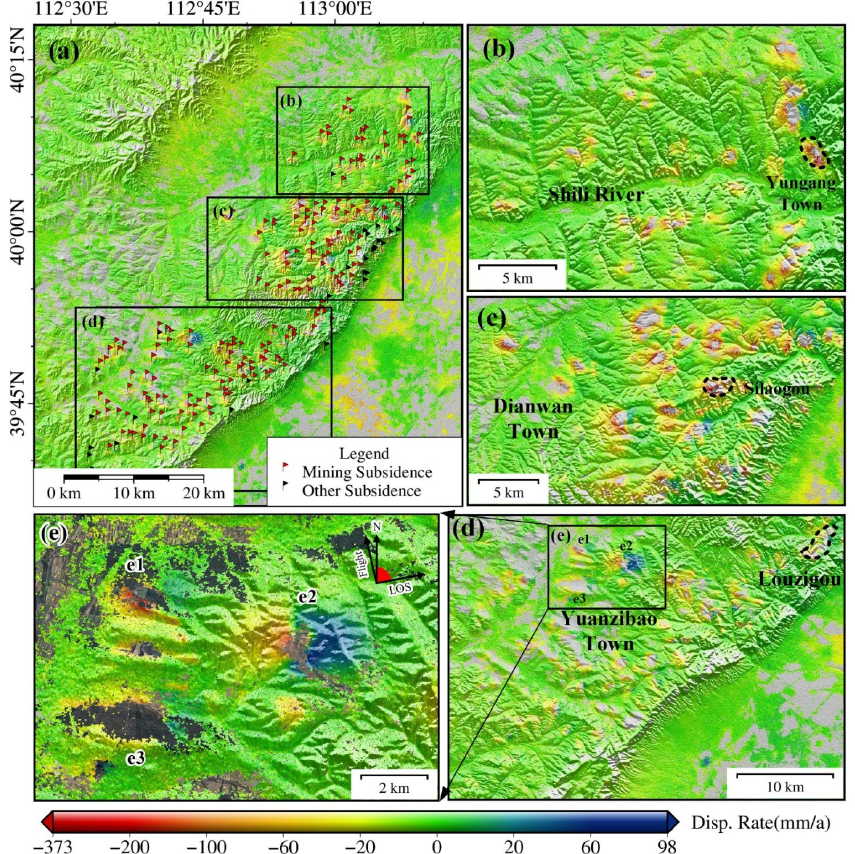
Figure 7. The SBAS-InSAR results of the displacement rate: ( a ) is the SBAS-InSAR result in the whole study area; ( b – d ) are enlarged to show the three typical areas in ( a ); the dotted lines in ( b – d ) are the areas where the maximum deformation value is located; ( e ) is an enlarged subsidence region and interpretation based on optical remote sensing data. Table 2. Maximum displacement rate results monitored by stacking-InSAR and SBAS-InSAR.